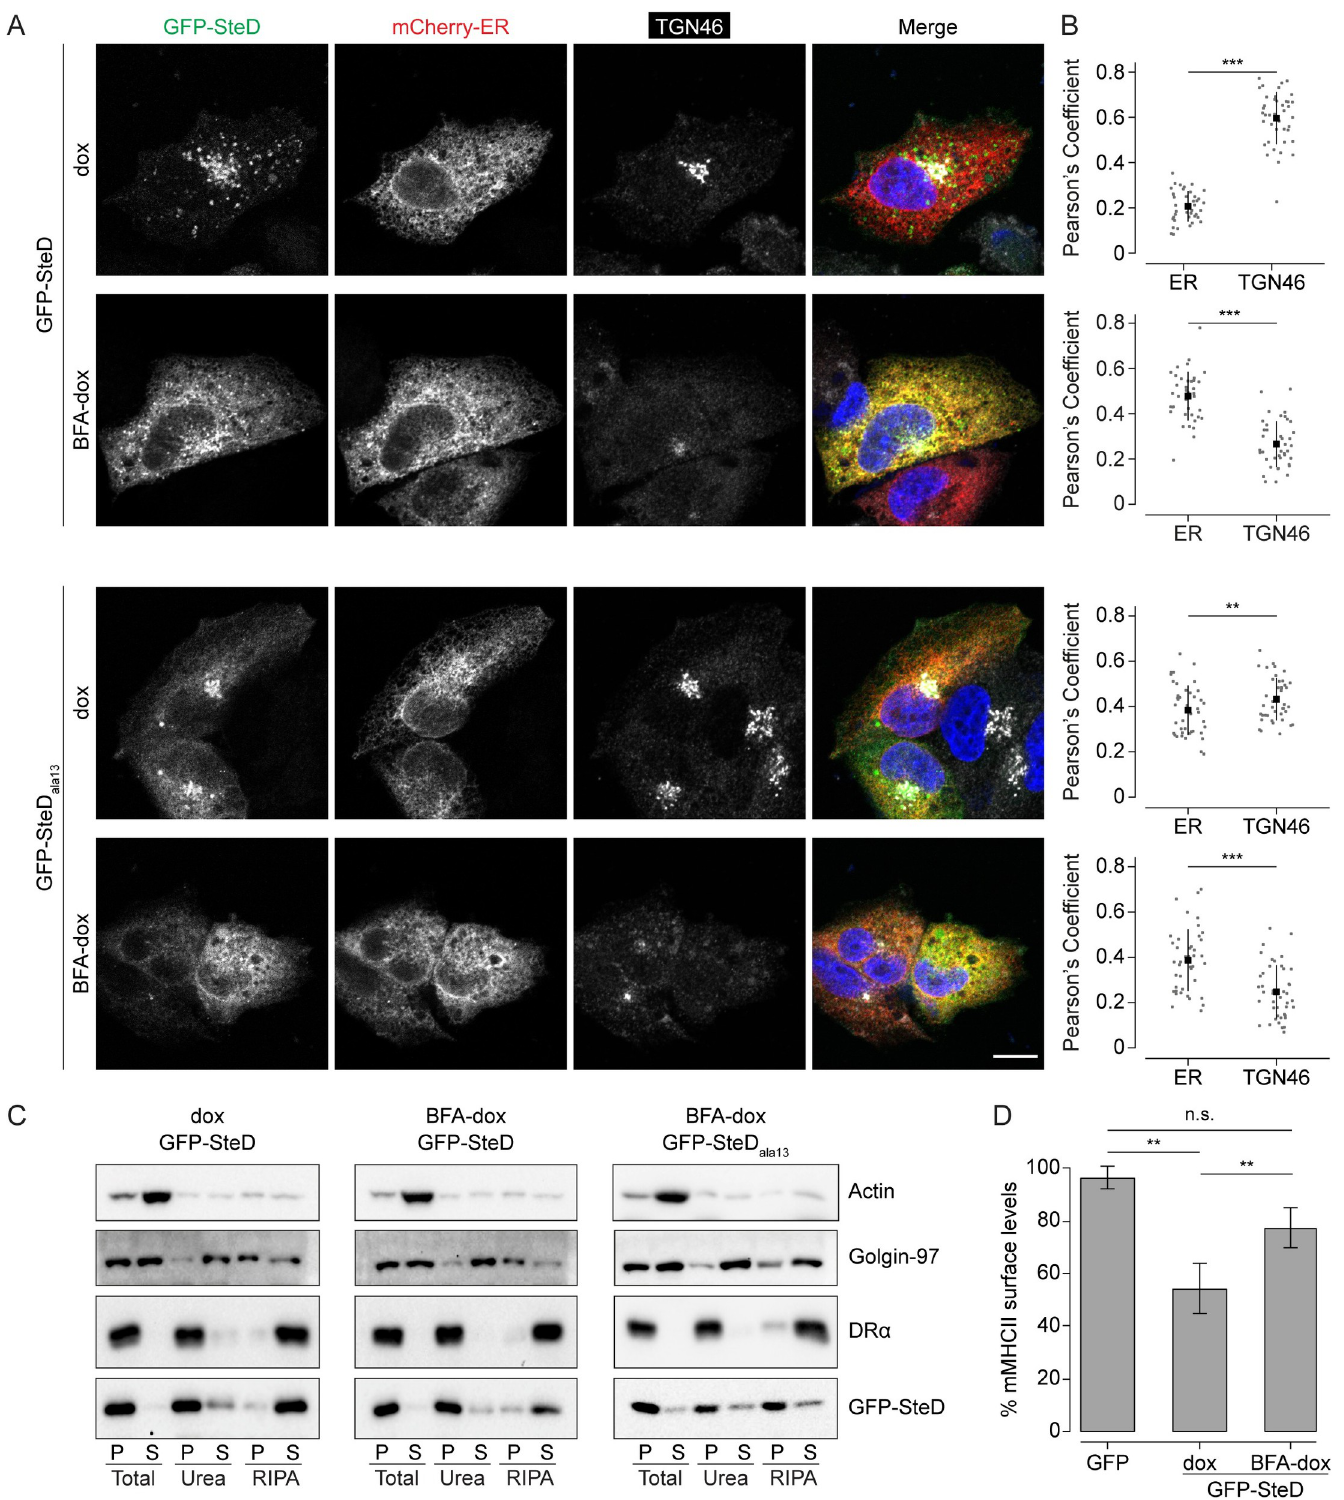
Fig 4. SteD integrates into membranes of the early secretory pathway. (A) Representative confocal immunofluorescence microscopy images of Mel JuSo cells expressing GFP-SteD (wt or mutant) under a doxycycline-regulated promoter and the ER marker mCherry-ER-3 (red). Cells were either treated with doxycycline plus MG132 (dox) or treated with BFA followed by doxycycline, MG132 and BFA (BFA-dox). Cells were then fixed and processed for immunofluorescence microscopy by